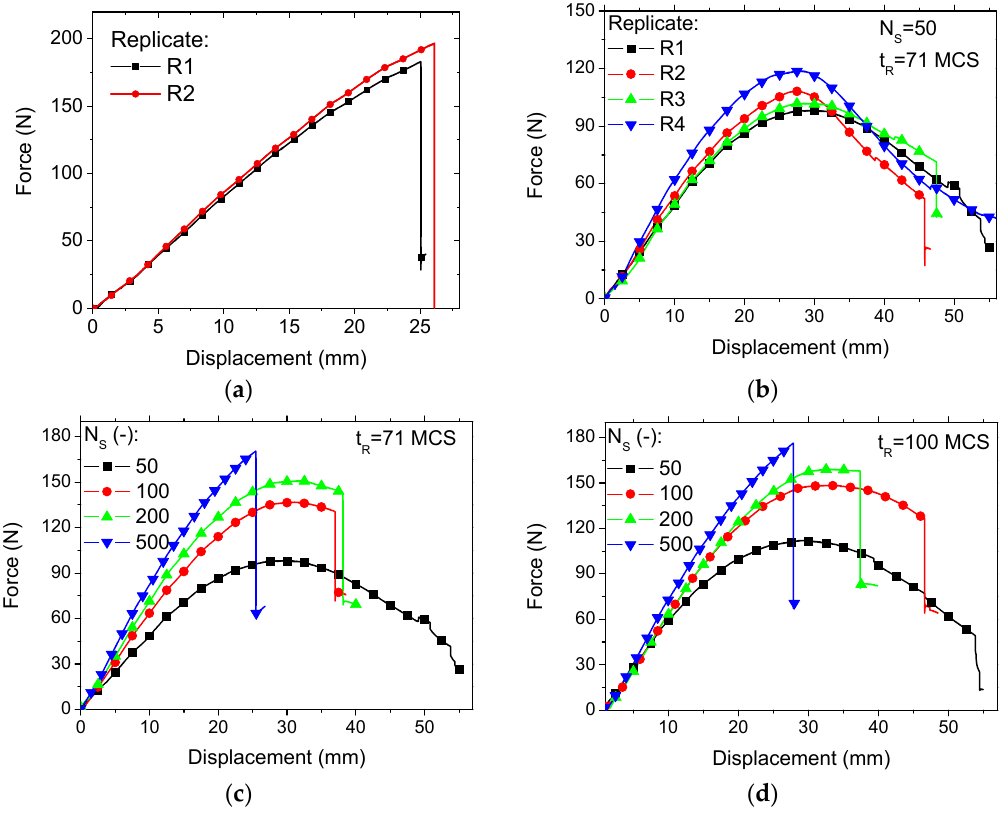
Figure 7. Result of bending experiment of 3D printed ( a ) fully solid and ( b – d ) cellular wrenches expressed as force–displacement curves for different ( b ) replicates and varied number of seed points N S combined with two relaxation times t R , ( c ) 71 MCS, ( d ) 100 MCS.